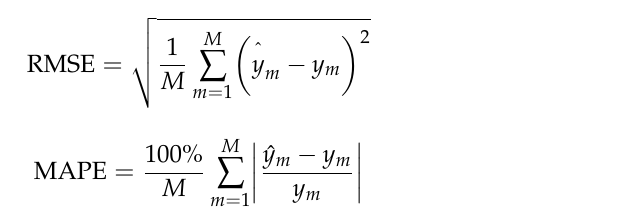
Figure 8. Dataset for March.